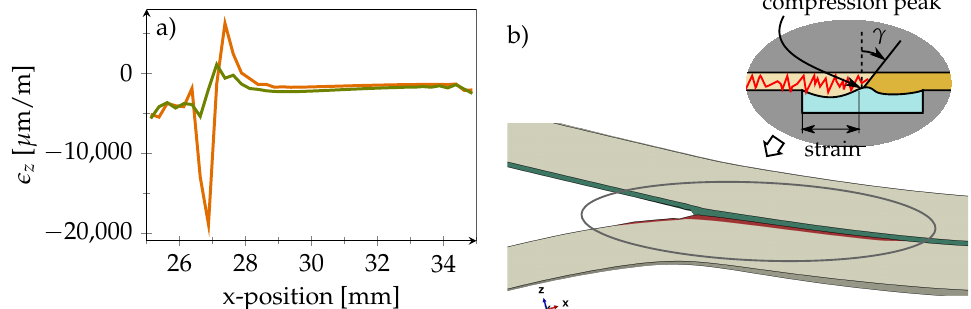
Figure 7. ( a ) 27 mm crack length. Nominal strain in z-direction in PVDF at different positions. Orange line represents PVDF-adhesive-interface while green line visualizes the PVDF-CFRP-interface. ( b ) 20 % exaggerated FE-deformation of strap. Insert shows sketch of PVDF strip deformation with intruded crack. Shear angle γ within adhesive layer is